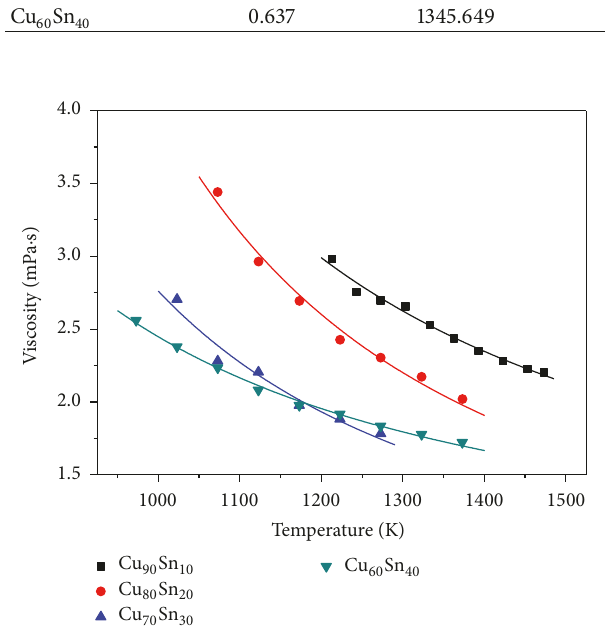
Figure 1: Temperature dependence of viscosities of Cu-Sn alloys (the lines are fitted by Arrhenius equation).